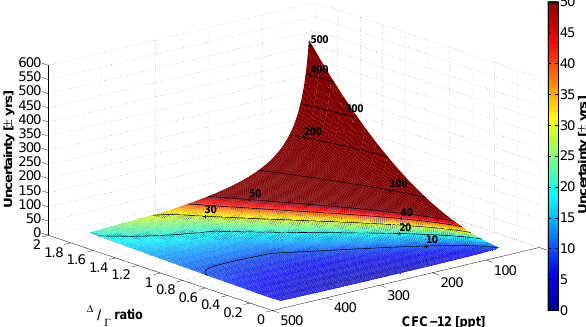
Figure 5. Absolute error of mean age calculations depending on CFC-12 concentrations and 1 / 0 ratios. The color coding is re- stricted to a maximum of 50 years for an improved error resolution of the main